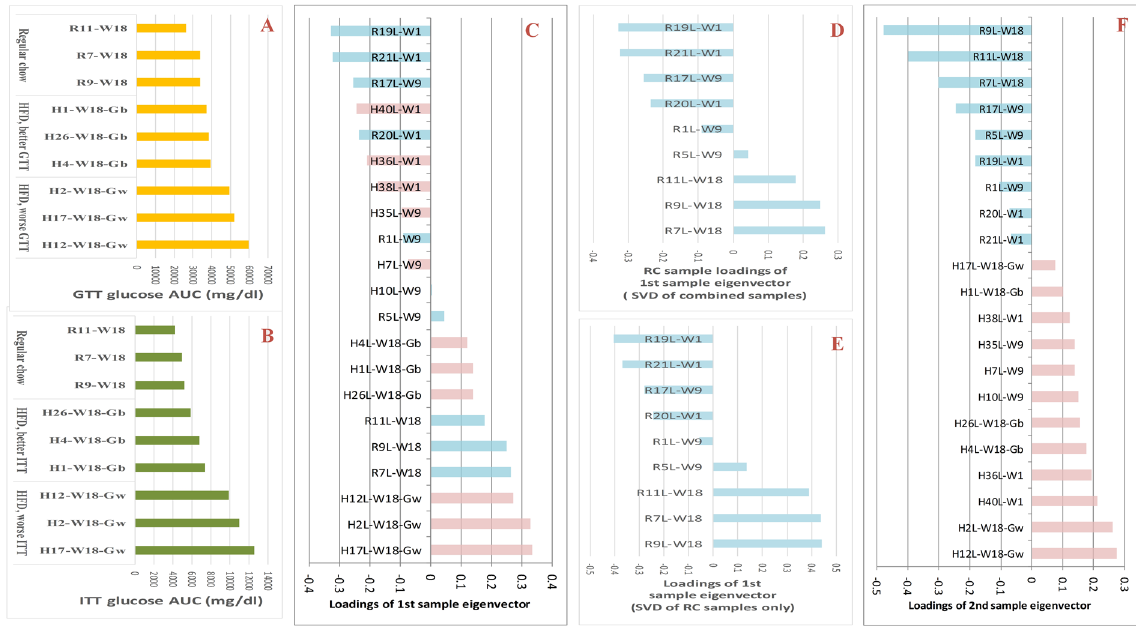
Figure 2. The sorted loadings of the top hepatic sample eigenvectors and their interpretations. ( A , B ) The AUC (area under curve) results of GTT and ITT of mouse samples from week 18 were respectively sorted in the ascending order. Shown from top to bottom are the sub-groups of RC, HFD-W18-Gb, and HFD-W18-Gw accordingly. ( C ) The sorted loadings of the hepatic first sample eigenvector from the SVD of the HFD and RC samples. The samples from week 18 were at the bottom. Similar to the ITT ( B ) and GTT ( A ) sorting, the HFD-W18-Gb subgroup located on top of the HFD-W18-Gw subgroup, and even further, on top of the RC samples at week 18. ( D ) Derived from ( C ) by keeping only RC samples. ( E ) When SVD was carried out only for the RC hepatic samples, the sorted loading of its first sample eigenvector displayed a chronological order. The consistency between ( D ) and ( E ) indicates that the first eigen-component reflected an endogenous state of the liver. ( F ) the sorted loadings of the second sample eigenvector from the SVD of the combined samples. The clear-cut separation of the RC and HFD samples indicates that the second hepatic eigen-component reflected the driving impact from HFD.